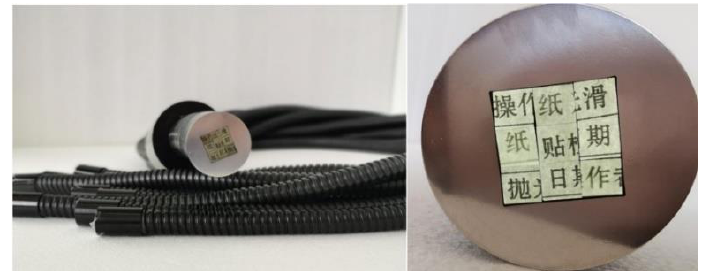
Figure 2. The end face of the optical fiber bundle.